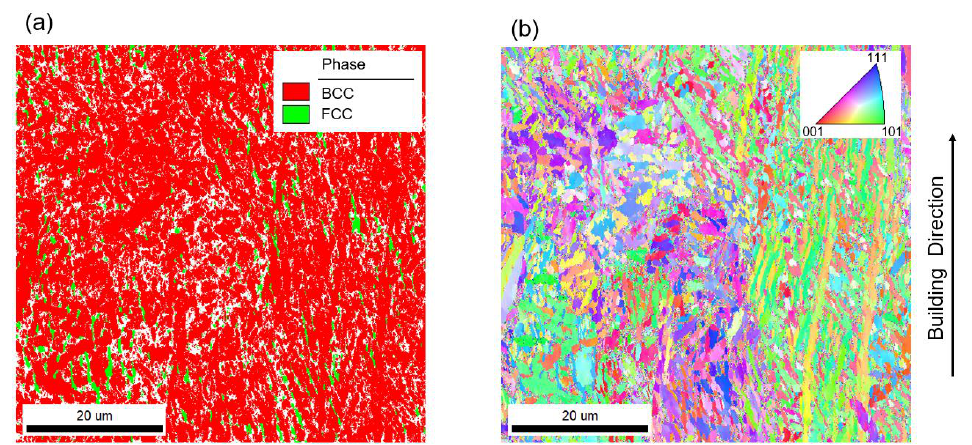
Figure 8. Electron Backscatter Diffraction (EBSD) phase map ( a ) and inverse pole figure map ( b ) of as-built sample produced at 250 °C.